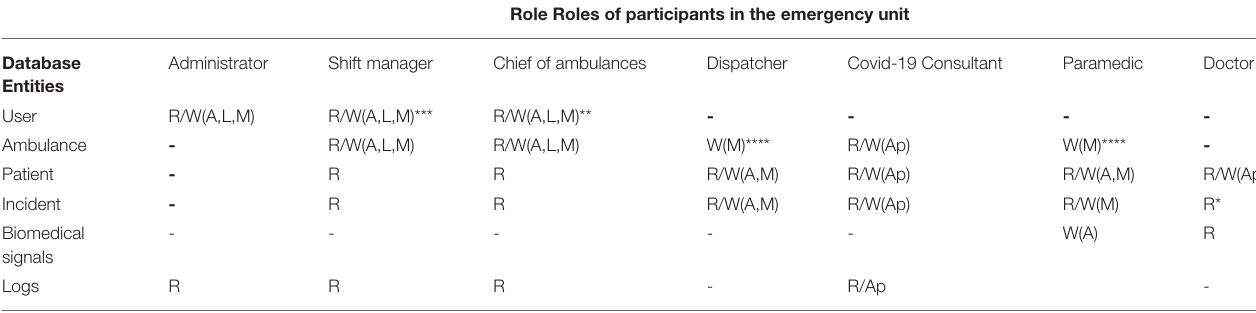
TABLE 1 | Role based access control to the different modules of the